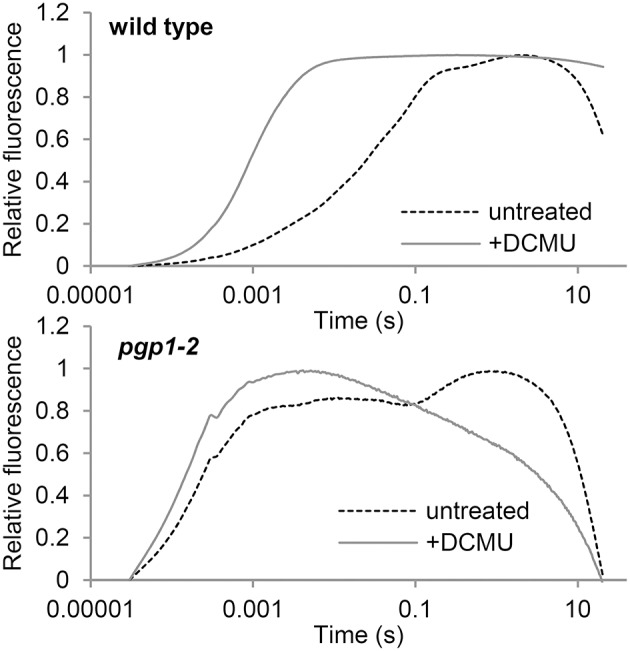
Transient fluorescence induction kinetics of chlorophyll in leaves treated with or without DCMU. Data are means from 3 independent experiments.